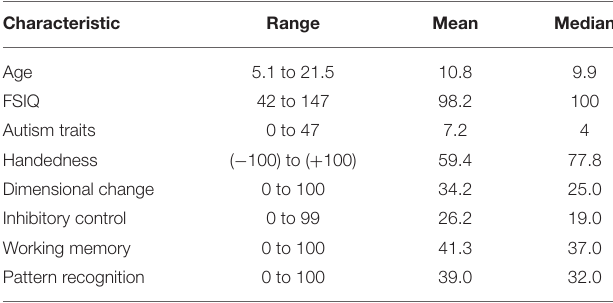
TABLE 1 | Demographic and cognitive characteristics of participant